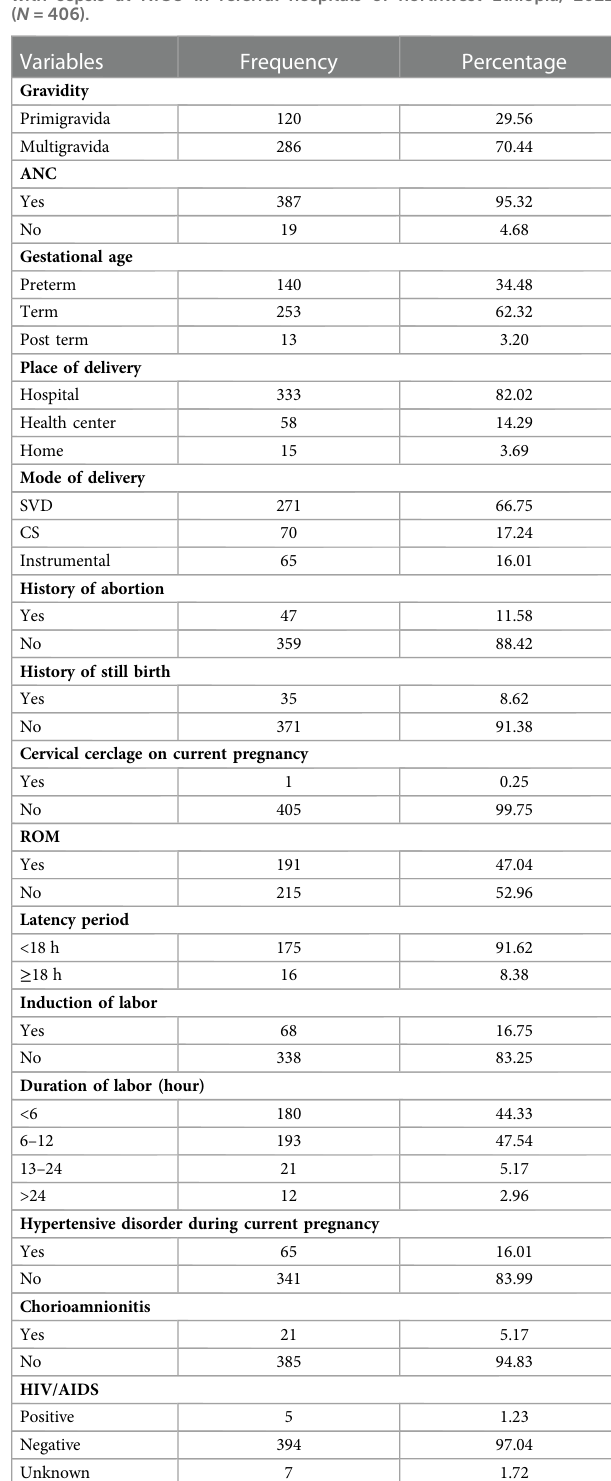
than 2,500 g compared to normal birth weight neonates. The TABLE 3 Obstetrical characteristics of mothers of the neonates admitted